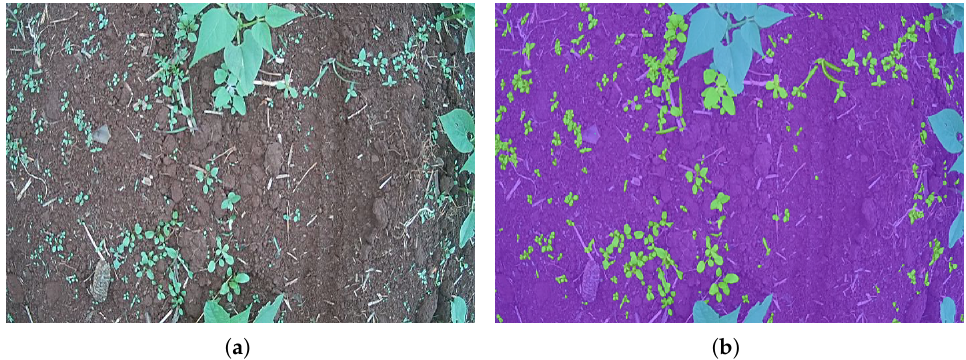
Figure 1. Example of semantic segmentation in an agricultural image. ( a ) RGB image. ( b ) Segmenta- tion